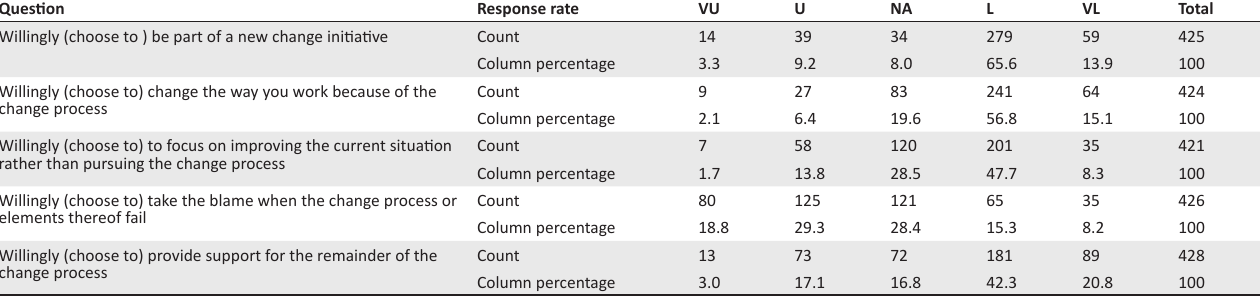
TABLE 11: The willingness of employees to be part of a change process.